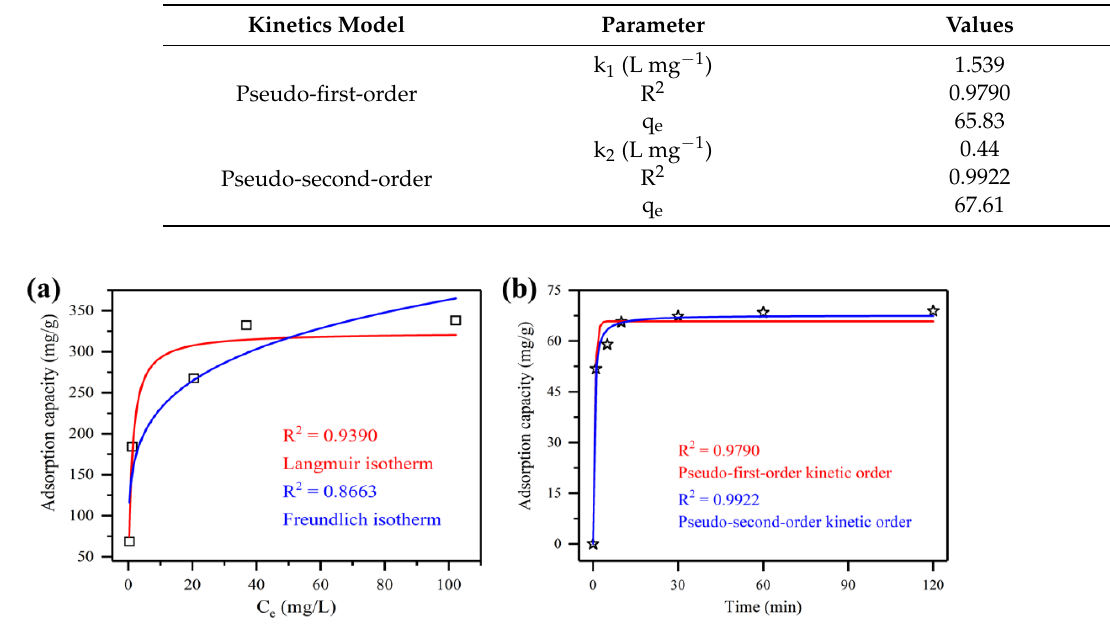
Figure 3. Isotherms and kinetics of U(VI) adsorption onto the as-fabricated HAP@CoFe 2 O 4 composite: ( a ) Langmuir isotherm and Freundlich isotherm models, ( b ) pseudo-first-order and pseudo-second-order kinetics. Table 2. Kinetic parameters for the adsorption of U(VI) onto HAP@CoFe 2 O 4 .